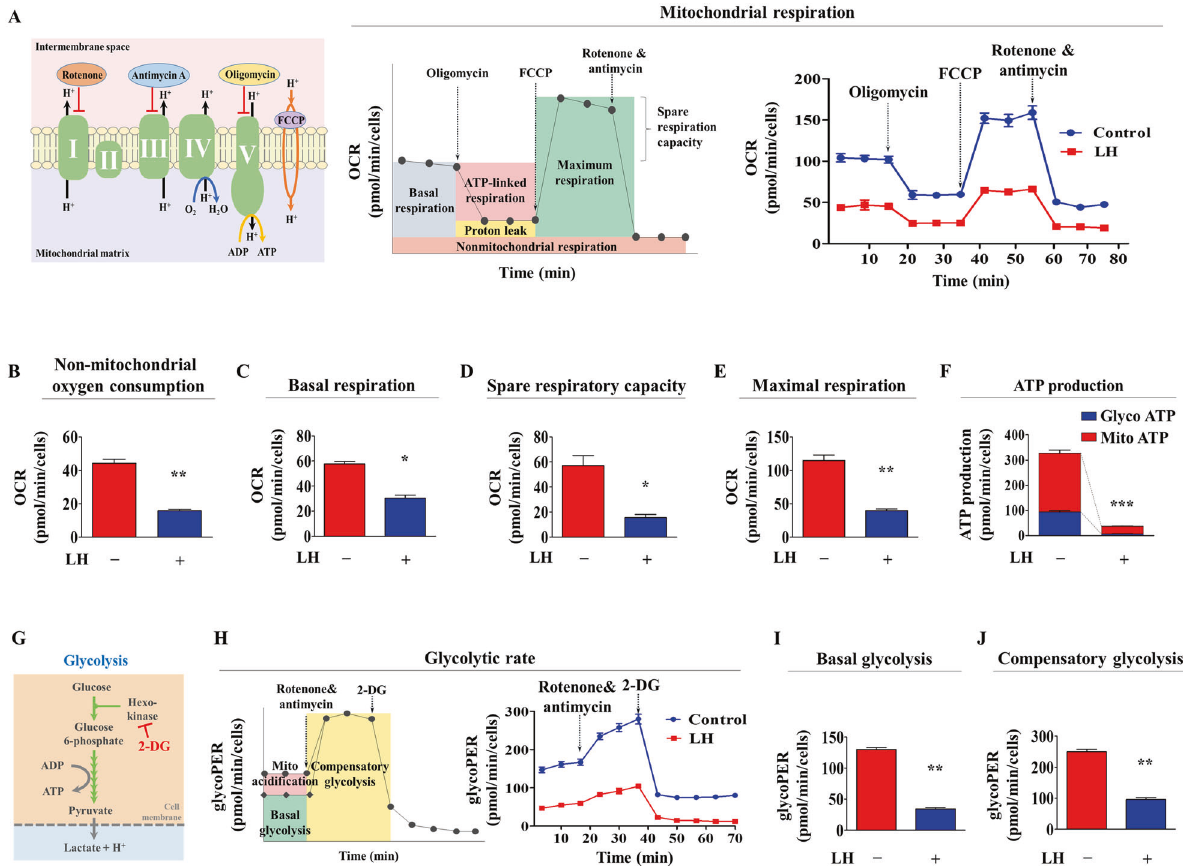
Fig. 2 LH treatment triggers energy metabolic switching in endometrial stem cells. To evaluate the effect of LH treatment on energy metabolism in endometrial stem cells, oxidative phosphorylation or glycolysis were determined after treating or not treating cells with LH (25 nM) for 72 h. Oxidative phosphorylation pro fi les in the mitochondria were evaluated by monitoring oxygen (O 2 ) consumption rates (OCR) simultaneously using a Seahorse XF fl ux analyzer (Seahorse Biosciences) ( A ). Cells were seeded at a density of 20,000 cells per well density in multi-well plates containing the growth medium. The seeded cells were then treated with 1.5 μ M oligomycin ATP synthase inhibitor (also known as a complex V blocker) to inhibit coupled respiration (respiration related to ATP synthesis), 2 μ M FCCP to disrupt the proton gradient ( Δψ m) across the mitochondrial membrane, 0.5 uM rotenone, and 0.5 uM antimycin A to completely collapse mitochondrial electron transport. These inhibitors were automatically injected into each well, and real-time OCR was recorded every 15 mins. LH treatment decreased the overall mitochondrial respiration capacity and nonmitochondrial OCR of endometrial stem cells ( B ). LH treatment also suppressed the levels of basal mitochondrial respiration potential ( C ), spare respiratory capacity ( D ), and maximal respiratory capacity ( E ). ATP production decreased remarkably upon LH treatment in both the cytosol and mitochondria ( F ). Glycolytic rates of endometrial stem cells are determined by measuring the real-time OCR and ECAR (extracellular acidi fi cation rate) to analyze glycolytic proton ef fl ux rates (glycoPER) following various inhibitors treatments. Brie fl y, cells were incubated in a glucose-free medium with 1.67 μ M antimycin A, rotenone, and 50 mM 2-deoxyglucose (2-DG, glycolytic inhibitor) treatments ( G ). Compensatory glycolysis is the glycolytic capacity of cells after preventing mitochondrial respiration and compensating ATP production through glycolysis to meet sudden energy demand. The overall glycolytic capacity of the endometrial stem cells signi fi cantly decreased upon LH treatment (25 nM) for 72 h ( H ). LH treatment also decreased basal ( I ) and compensatory ( J ) glycolysis. Glycolytic ECAR measurements were normalized by the cell numbers in each well. Bar graphs represent the averages of three independent experiments. Signi fi cant differences are presented as * p < 0.05, ** p < 0.005, and *** p < 0.001 (two-sample t